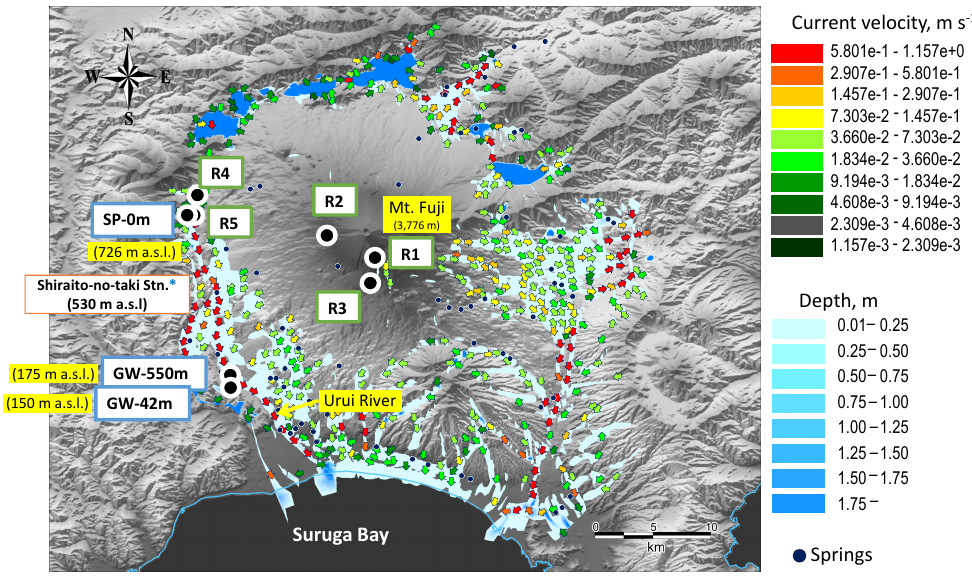
Figure 1. Study sites in western foot of Mt. Fuji. Red arrows indicate main fast flow (GETFLOWS; Kato et al., 2015, partially modified). Precipitation was sampled at R1 to R5. Groundwater was sampled at SP-0, GW-42, and GW-550m. R1 is located at 2364ma.s.l., R2 is at 1431ma.s.l., R3 is at 1081ma.s.l., R4 is at 850ma.s.l., and R5 is at 723ma.s.l. SP-0m, spring water, shows the sampling site of Shibakawa, located at 726ma.s.l. GW-42m, shallow well water obtained from 42m, is located at Yodoshi at 150ma.s.l. GW-550m, deep well water obtained from 550m, is located at Aoki at 175ma.s.l. The asterisk indicates that the amount of precipitation for the studied area was recorded at Shiraito-no-taki Station of Japan Weather Association.